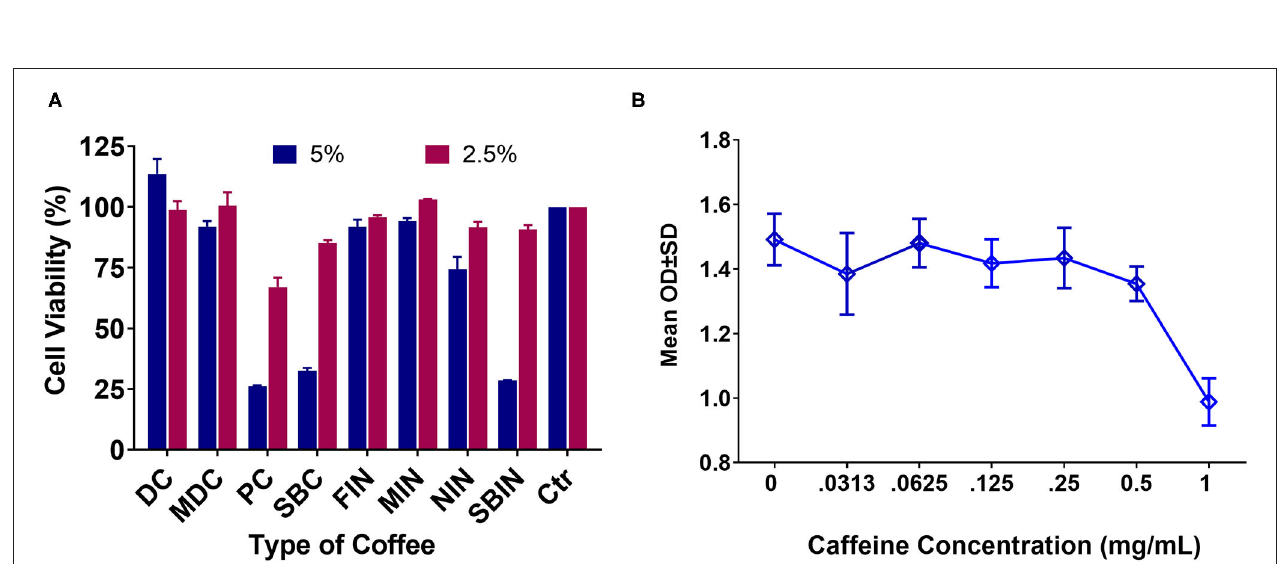
FIGURE 2 | Cell toxicity via MTT assay of different coffees and pure caffeine at different concentrations in N2a/APPswe cells ( N = 4). (A) Cell toxicity results of commercial coffees and instant coffees at 5 and 2.5% concentrations. Cell control is set at 100% viability, so any results lower than 100% considered toxic and results higher than 100% showing potential for cell proliferation. (B) Pure caffeine toxicity to Na2/APPswe cells via MTT assay.